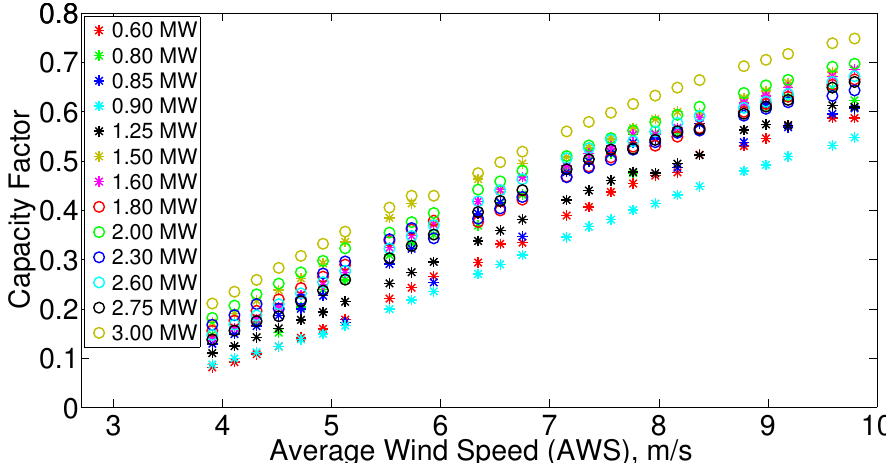
Figure 7. The capacity factor given by the best performing turbines (of each rated-power class) for each sample AWS.